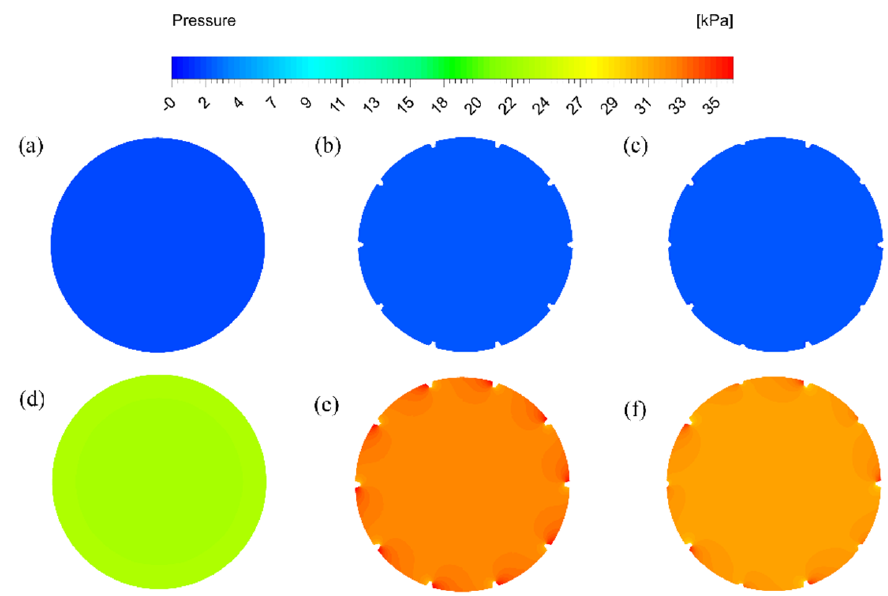
Figure 7. Pressure contours at inlet cross-section ( a ) Smooth tube, Re 12,000; ( b ) Fin-to-Fin height 1:1,